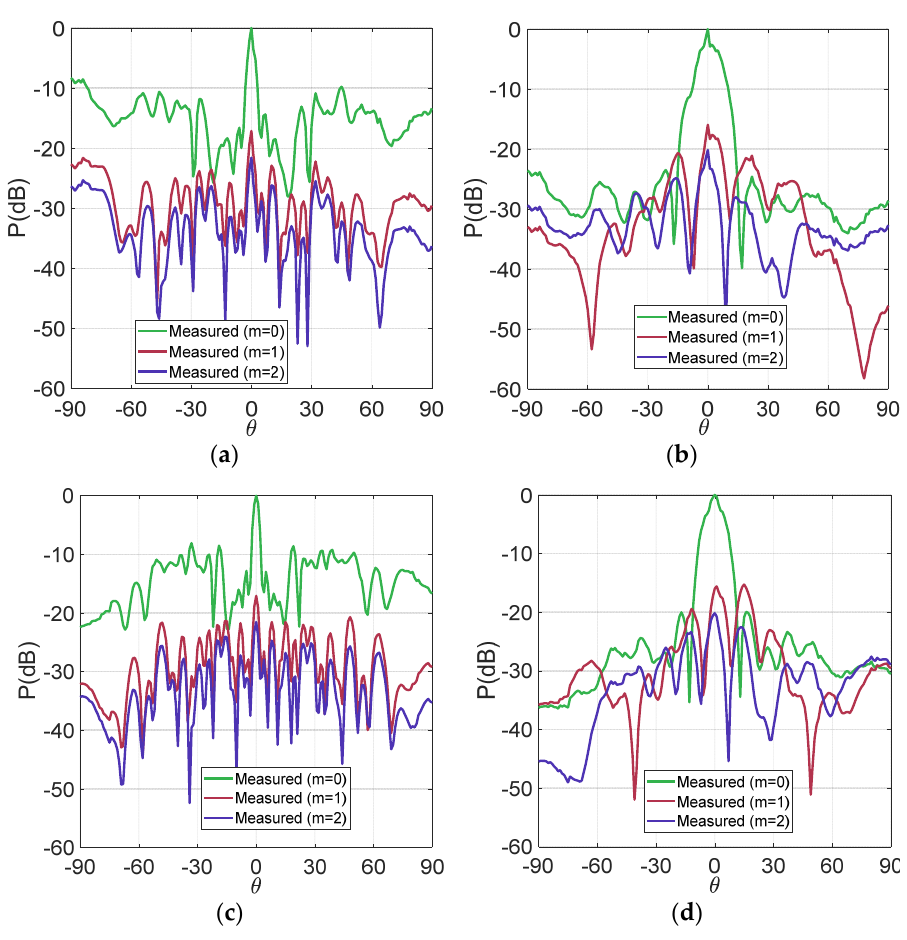
Figure 6. Measured patterns: ( a ) non ‐ uniform TMA at 3.4 GHz; ( b ) uniform TMA at 3.4 GHz; ( c ) non ‐ uniform TMA at 4.4 GHz; ( d ) non ‐ uniform TMA at 4.4 GHz. The sideband level reduction appears as SBL < − 17 dB. Figure 7 contains the repre ‐ sentation of directivity and SLL versus frequency. We extracted the data of directivity and side ‐ lobe level from different radiation patterns. The frequency range was established from fr = 2.97 GHz to fr = 5.26 GHz in steps of 0.2 GHz. Particularly, Figure 6a presents the around 11 dB, and the directivity of the uniform array varies from 12 dB to 14.5 dB in the UWB range. Figure 6b illustrates the SLL performance, the SLL for the uniform array is on average − 21 dB, and the SLL for the non ‐ uniform array is around − 7 dB in all of the UWB frequency ranges.